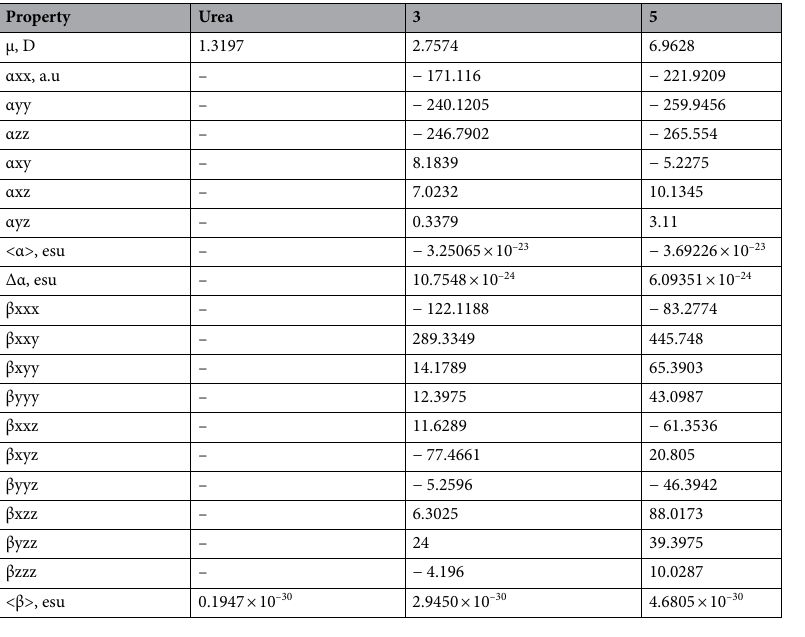
Table 3. Calculated total static dipole moment (μ), the mean polarizability <α> , anisotropy of the polarizability Δα and the first-order hyperpolarizability <β> configuration for the studied 3 and 5 compounds using